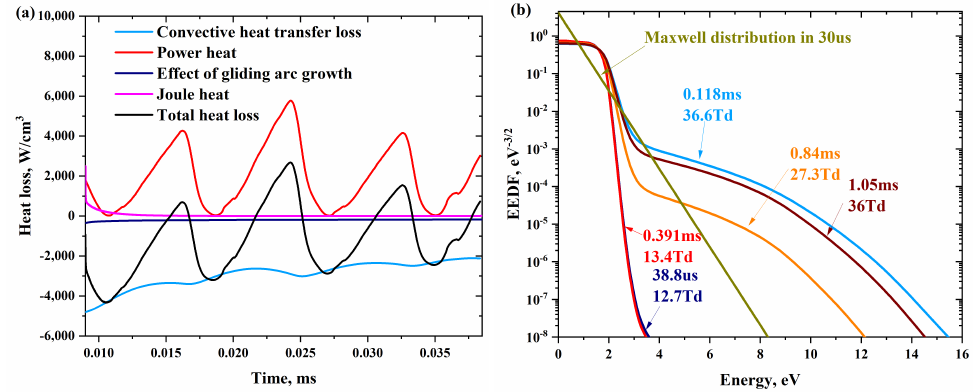
Figure 10. ( a ) Source rate analysis of the gas temperature and ( b ) the changes of EEDF during the